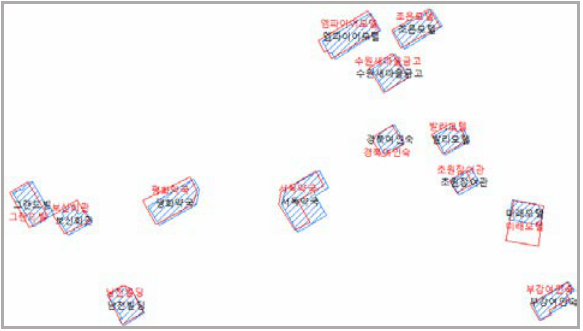
Figure 2. Areal Features that are same building name in different spatial datasets